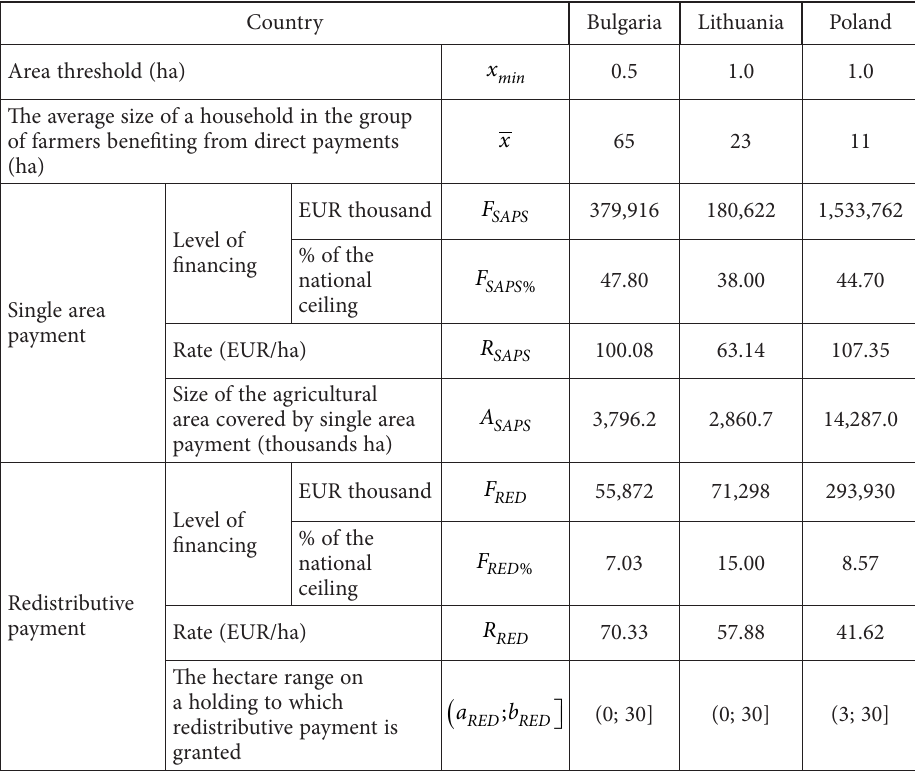
Table 1. Source data used in the research, referring to 2018 (source: European Commission, 2019 – data on area thresholds; the Ministry of Agriculture, Food, and Forests of the Republic of Bulgaria, the Ministry of Agriculture of the Republic of Lithuania, the Ministry of Agriculture and Rural Develop- ment of the Republic of Poland – other data concerning Bulgaria, Lithuania and Poland, respectively) Country Bulgaria Lithuania Poland x 0.5 1.0 min The average size of a household in the group of farmers benefiting from direct